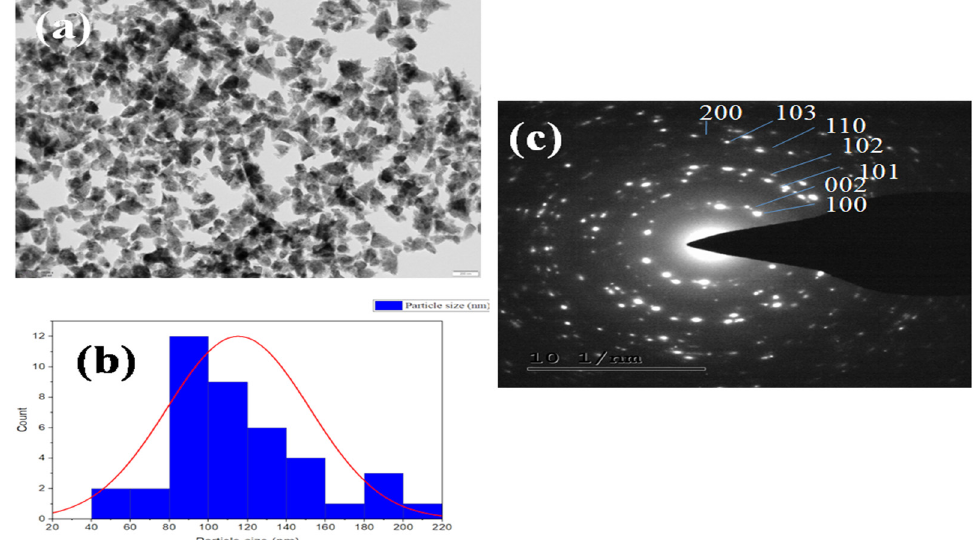
Figure 4. ( a )SEM image and ( b ) EDX spectrum of N-ZnO Ps.